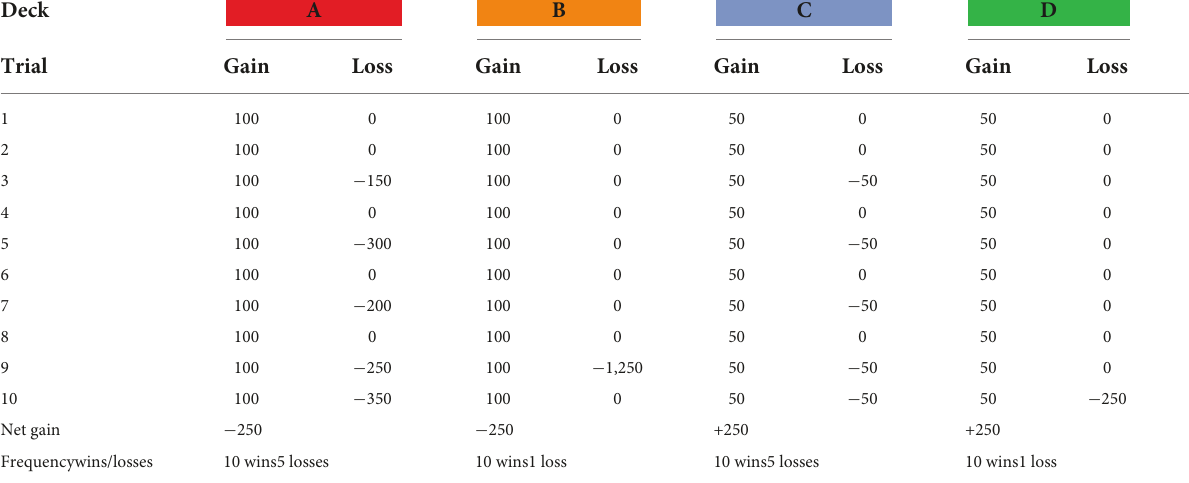
TABLE 1 The win-loss-contingencies (in SEK) during the first 10 trials and repeated throughout the IGT.